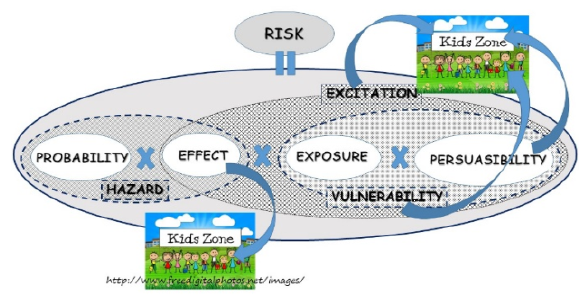
Figure 1. Kids zone in natural risk